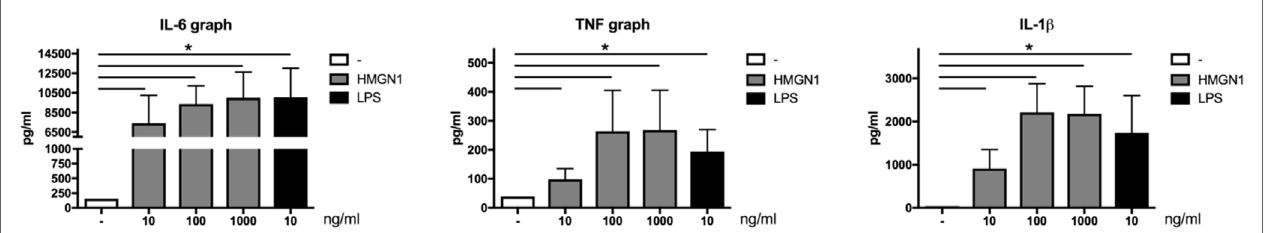
FigUre 1 | High-mobility group nucleosome-binding protein 1 (HMGN1) induces pro-inflammatory cytokine production. Human peripheral blood mononuclear cells were stimulated with recombinant HMGN1 or lipopolysaccharide (LPS) in a dose-dependent manner. HMGN1 concentration used were 10, 100, and 1,000 ng/ml, and LPS concentration was 10 ng/ml. Supernatant was harvested after 24 h stimulation. IL-6, TNF- α , and IL-1 β production was determined by ELISA ( n = 6).